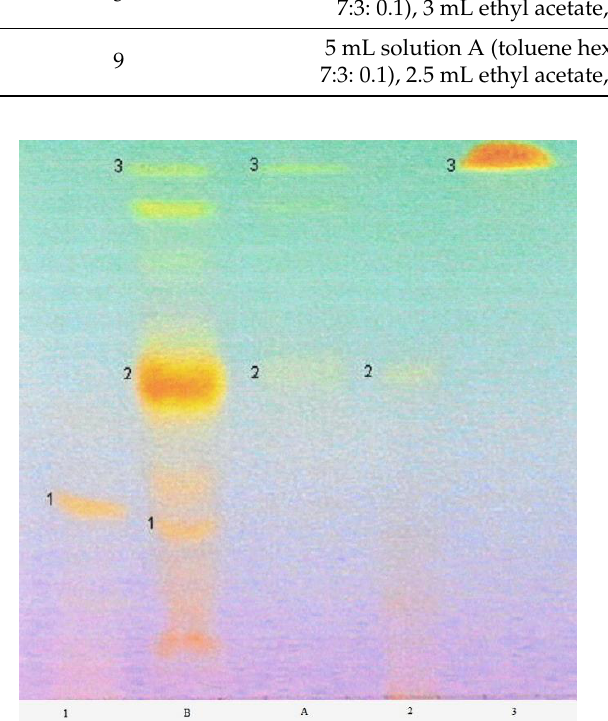
Figure 7. Chromatogram of the separation of flavonoids in methanol extract from L. album subsp. album flowers with the multiple gradient development technique (MGD). The bands of the standards correspond with the bands of the compounds in the extract: 1—rutoside; 2—isoquercetin; 3—quercetin; A—ethyl acetate extract-excluded from the investigations; B—methanol extract. Visible light, derivatization with the use of a 1% methanolic solution of aluminum chloride. The mobile phase elution program is given in Table 2. Chromatographic plate HPTLC Si 60 F 254.